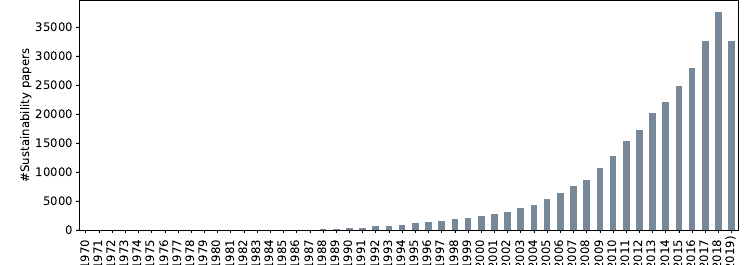
Figure 1. Number of papers relating to sustainability science in each year. (Not all papers published in 2019 have been included in Scopus